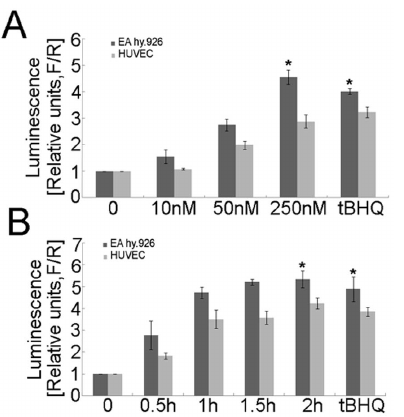
Figure 1. Identification of S- (-)equol as an Nrf2 activator. Where indicated, EA.hy926 cells or HUVECs were transfected with plasmids containing an ARE-dependent firefly luciferase reporter gene ( F ) and the renilla firefly luciferase gene ( R ), the latter of which was included in each transfection reaction as a control for transfection efficiency. Medium was changed after 6 hours of incubation. (A) Cells were treated with S- (- )equol (10 nM, 50 nM, and 250 nM) or tBHQ (50 m M) for 16 h. (B) Cells were treated with S- (-)equol (250 nM) and tBHQ (50 m M) for the time periods indicated. The potency of induction is expressed as the relative luminescence (R/F) of the treated samples over the untreated transfected controls (mean 6 SD, n=3). * p , 0.05.